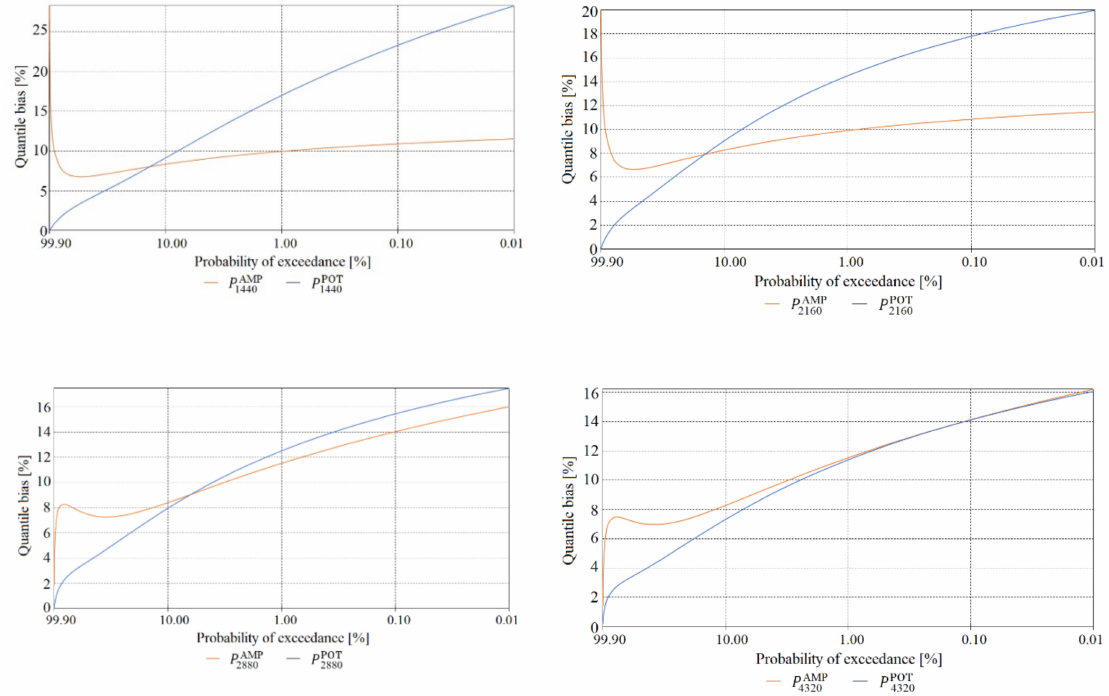
Figure 13. Comparison of estimated values of quantile error resulting from the randomness of the sample of maxi- mum precipitations computed using the PMAXTP method for the random variables P AMP τ and P POT τ with durations τ = {1440, 2160, 2880, 4320} min, for the Chojnice meteorological